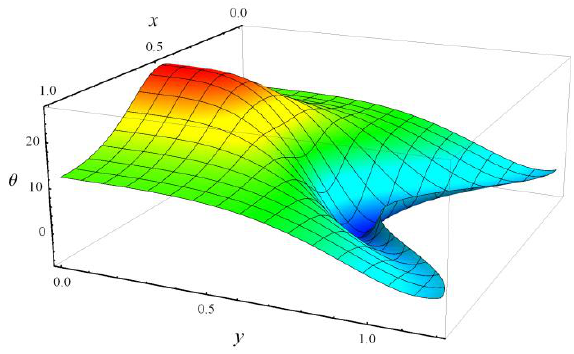
Figure 11. A 3D temperature profile fixing M = Br = 1, n = ε = 0.2, α = 0.1, We = 0.01, β = Fr = 0.5, ξ = π/3.